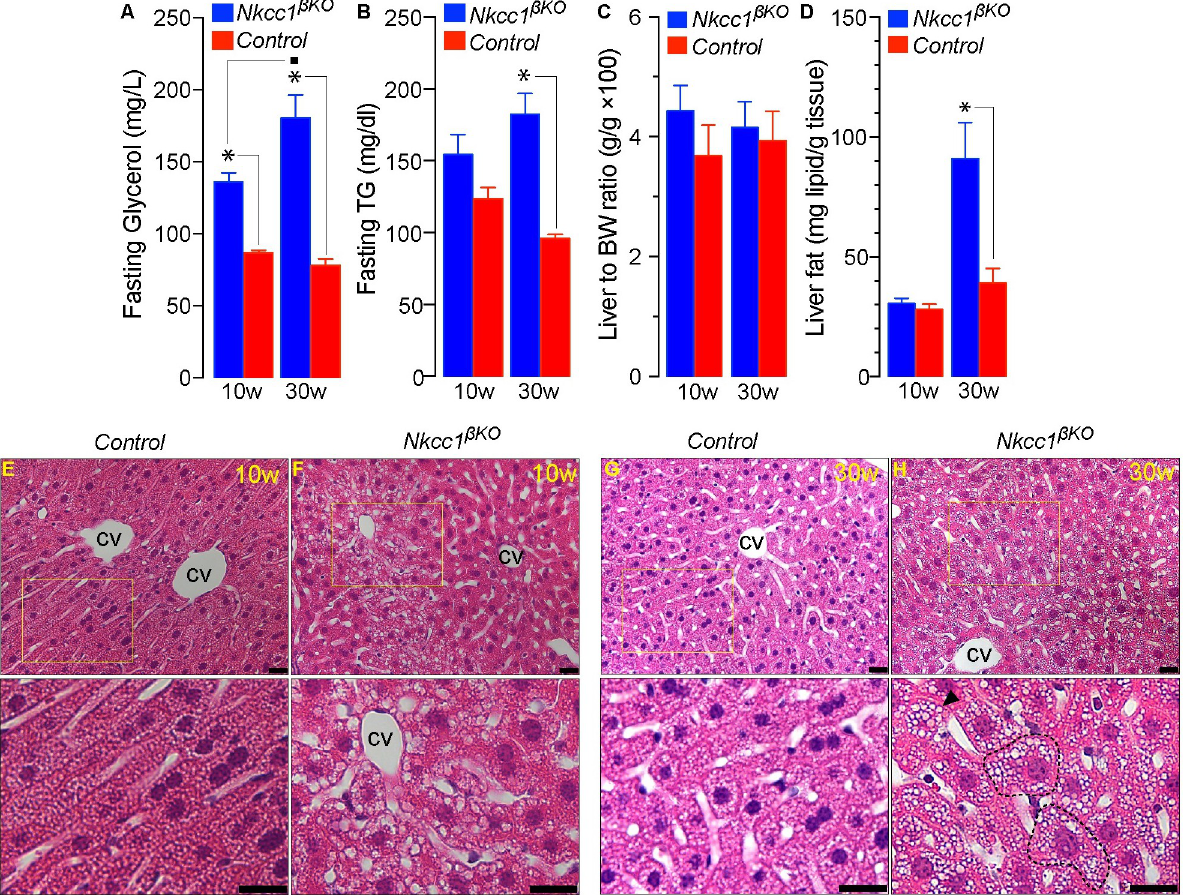
Fig 5. Plasma lipids, hepatic index, liver fat content and liver histopathology of Nkcc1 β KO mice. A, B . Plasma glycerol (A, mg/L) and triglycerides (B, TG mg/dl) of 10w and 30w old Nkcc1 β KO and control ( Ins1 Cre ) mice fasted 16h. Results represent the mean ± SEM ( n = 4–5, � p < 0.01). C, D . Plotted are the hepatic index (C) calculated as wet liver mass (g) relative to total BW (g), and the net fat content (mg) per gram of liver tissue (D) of Nkcc1 β KO and control ( Nkcc1 lox/lox ) mice at the indicated ages. Results are expressed as the mean ± SEM ( n = 5–6, � p < 0.001). E-H . Shown are representative H&E-stained liver sections of 10w (E-F) or 30w old (G-H) control ( Nkcc1 lox/lox , E and G) and Nkcc1 β KO (F and H) mice. The squares in E-H are shown magnified in the images below each one of them to depict histopathology changes including mild steatosis around a central vein (cv) in 10w old Nkcc1 β KO mice and hypertrophic hepatocytes (dashed-lined cells), micro- and macro-vesicular fat deposits in 30w Nkcc1 β KO mice, consistent with a more severe steatosis phenotype (see S4 Fig). Bars indicate 20 μ